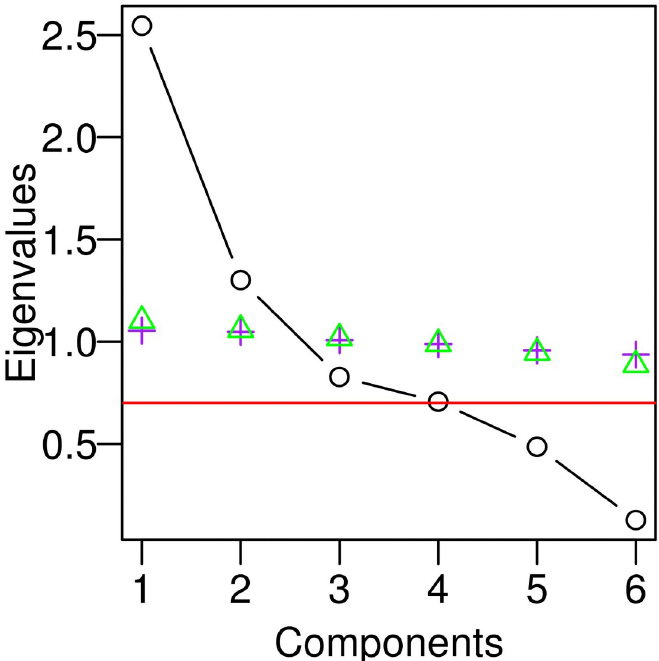
Fig 5. PCA variable selection scree plot with various cut-off lines. Parallel analysis, which generated a cut-off line based on a randomly simulated, similarly sized dataset (purple plus marks and green triangles), suggests retention of the first two components (left); Jolliffe’s cut-off ( λ < 0.71), determined via simulation on artificial data (red line), suggests a rejection of the last two components (right). The “elbow” of this plot lies between these horizontal cut-off lines, arguably at component three. The most important musical features suggested by these various procedures prominently include repetition, transposition, and syllable count.